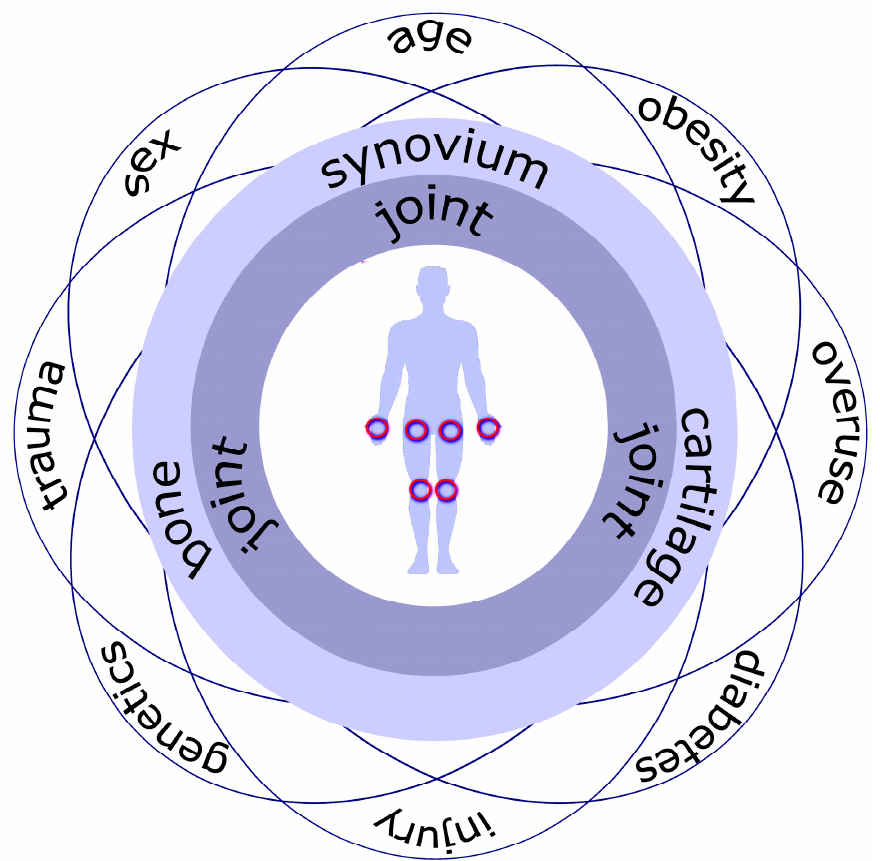
Figure 1. Common sites (red circles) and risk factors for OA: age, gender, genetics, metabolic state (obesity, type 2 diabetes), joint overuse, trauma, and injury that contribute to changes in the main joint compartments, namely, the synovial membrane, cartilage, fibrocartilage of meniscus, as well as subchondral bone.